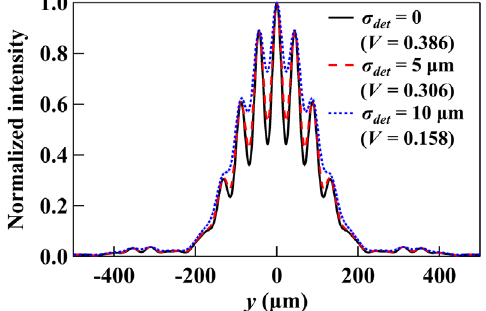
FIG. 9. Simulated double-slit interference profiles using near- field (Fresnel) calculation with different detector resolutions σ of a Gaussian PSF equals to 0 (solid curve), 5.0 (dashed curve), and 10 μ m (dotted curve). Other parameters are λ ¼ 0 . 827 Å ( E ¼ 15 keV), p ¼ 6 . 6 m, q ¼ 13 . 4 m, σ d ¼ 25 μ